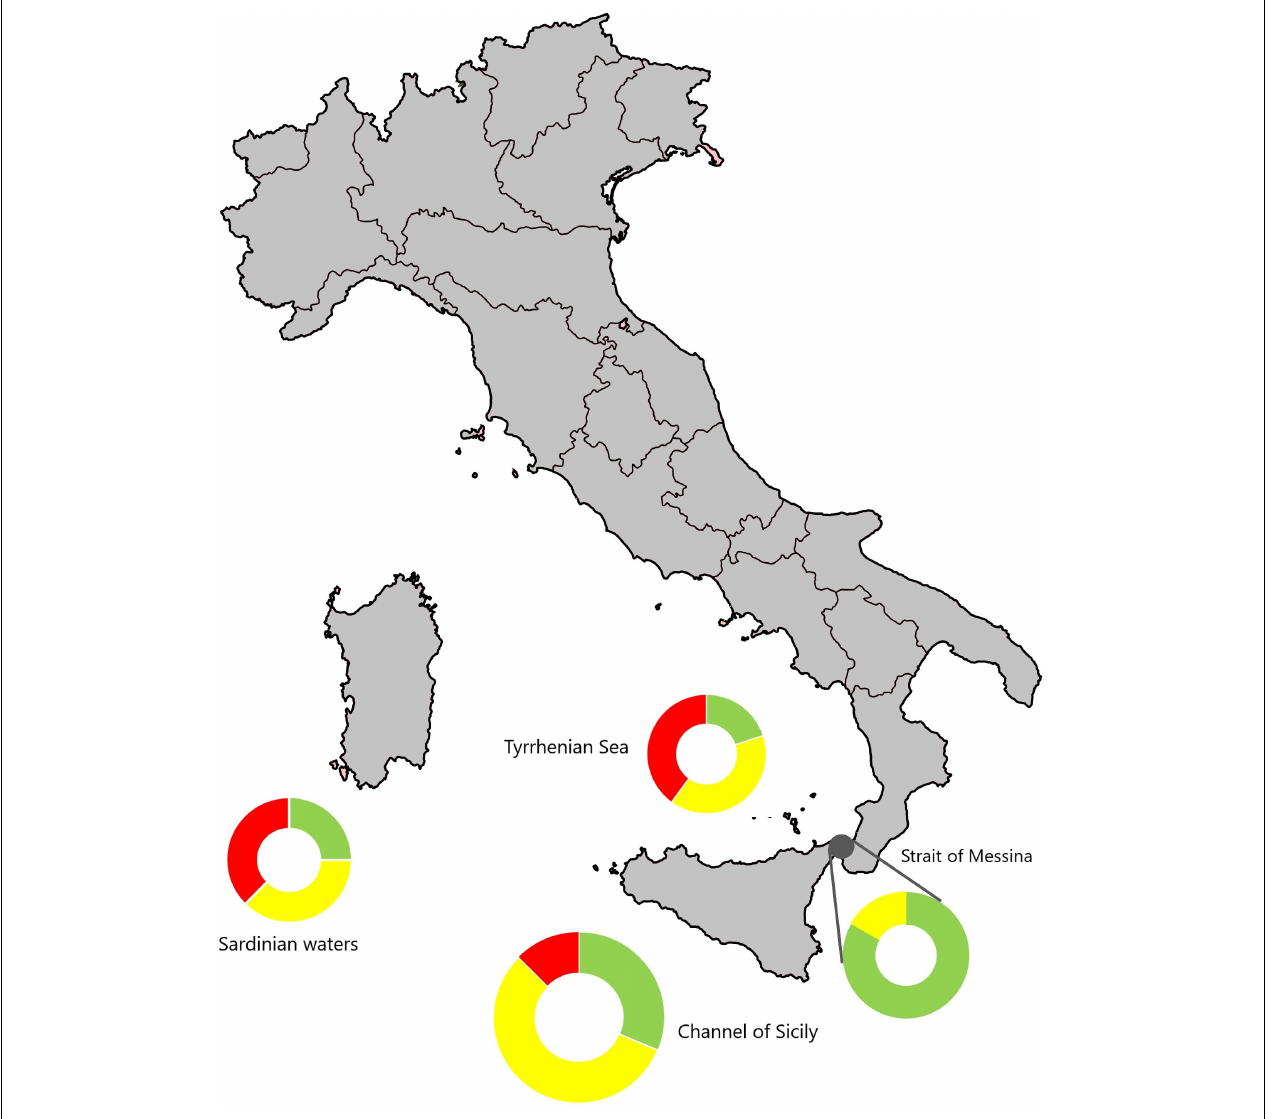
FIGURE 5 | A schematic clustering of the records of P. physalis in the Italian maritime zone (see Table 1 for details); the records were aggregated in four different geographic sectors (from west to east, Sardinian waters; Channel of Sicily; Tyrrhenian Sea;Strait of Messina), and categorizedto a level of risk as tool for tourism sector. The green records indicate the number of colonies sighted in the period February–March ( low-risk ); yellow is the number of colonies sighted in the period April–May ( medium-risk ); red is the number of colonies sighted in the period June–August ( high-risk ). The map can be be used by local and regional managers to assess the risk of having free floating P. physalis colonies intheir area of